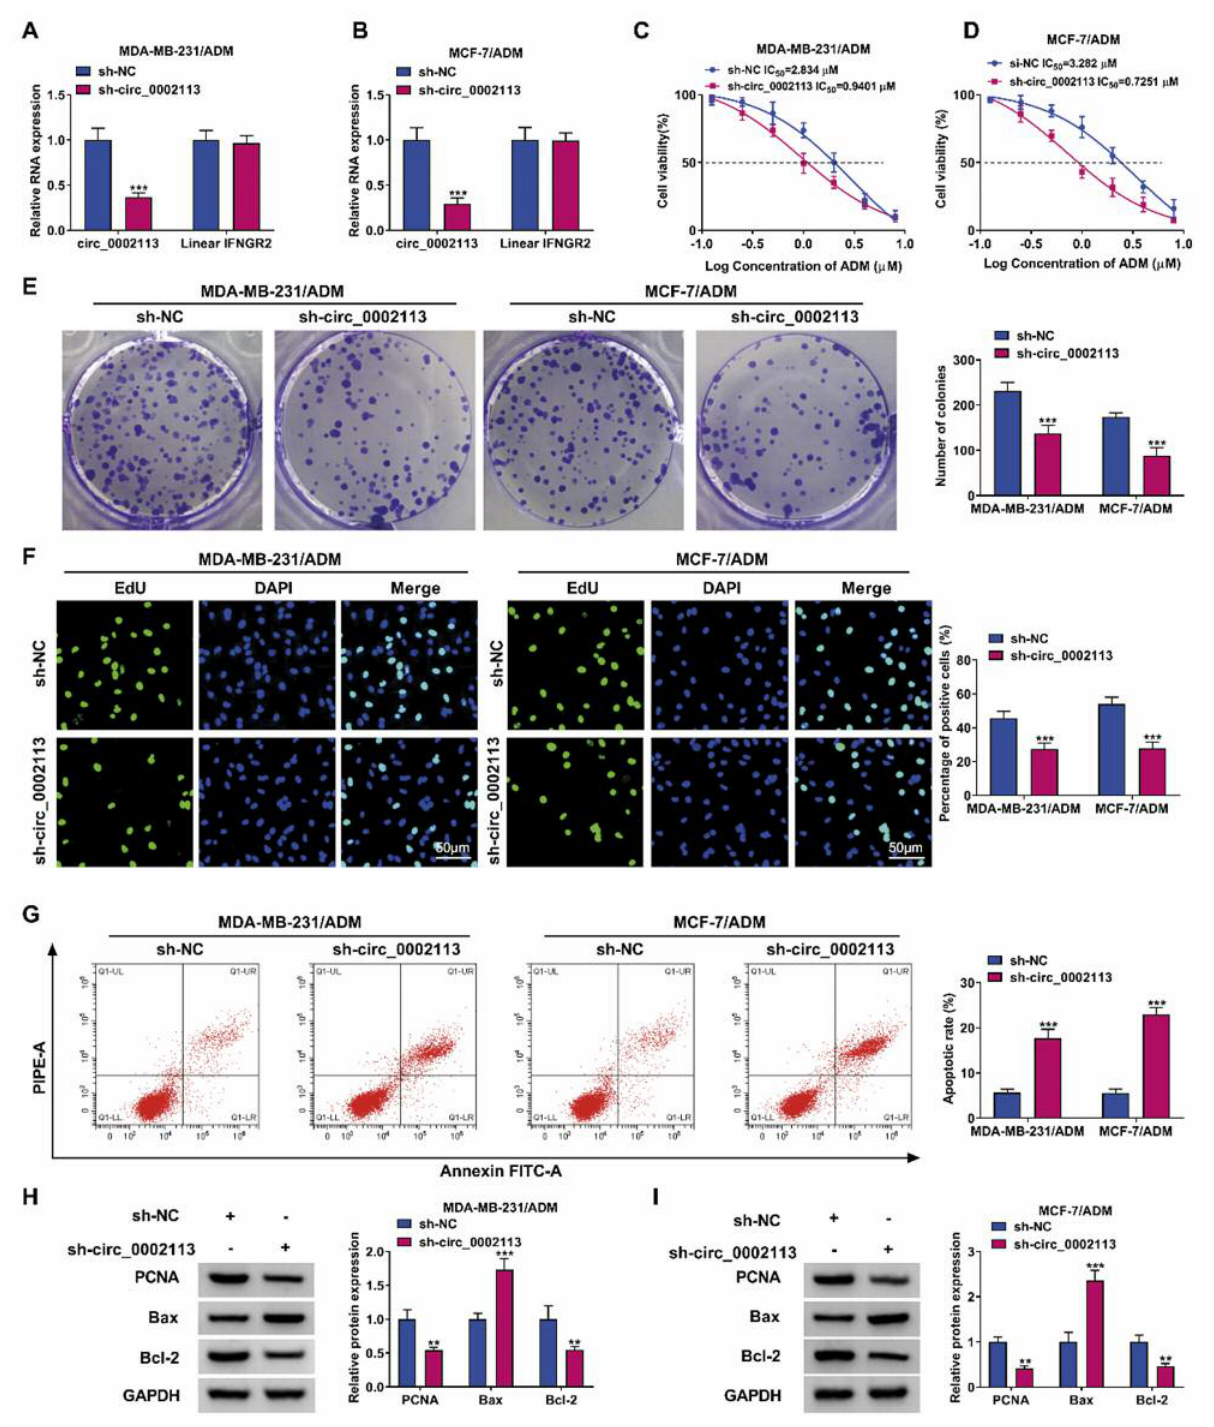
Fig. 2. Silencing circ_0002113 reduced ADM resistance and proliferation but accelerated apoptosis in BC cells. Transfection with sh-NC or sh-circ_0002113 was performed in MDA-MB-231/ADM and MCF-7/ADM cells. (A-B) RT-qPCR was applied for quantification of circ_0002113 and IFNGR2. (C-D) CCK-8 assay was applied for detecting IC of ADM. (E-F) Colony formation assay (E) and EdU 50 assay (F) were applied for assessing cell proliferation. (G) Flow cytometry was applied for examining cell apoptosis. (H-I) Western blot was applied for measuring protein levels of PCNA, Bax and Bcl-2. ** p < 0.01, *** p <